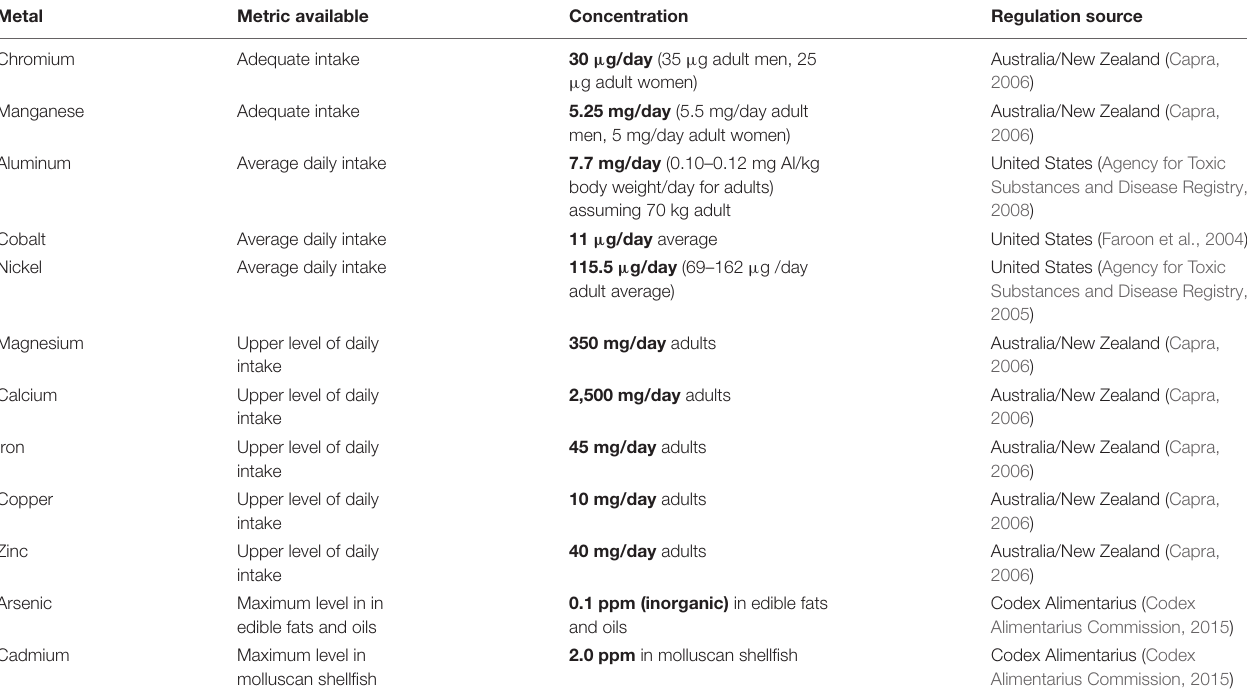
TABLE 1 | Regulations/recommendations for metal intake for adult humans for Cr, Mn, Al, Co, Ni, Mg, Ca, Fe, Cu, and Zn, and the maximum concentrations allowed in shellfish for As (inorganic) and